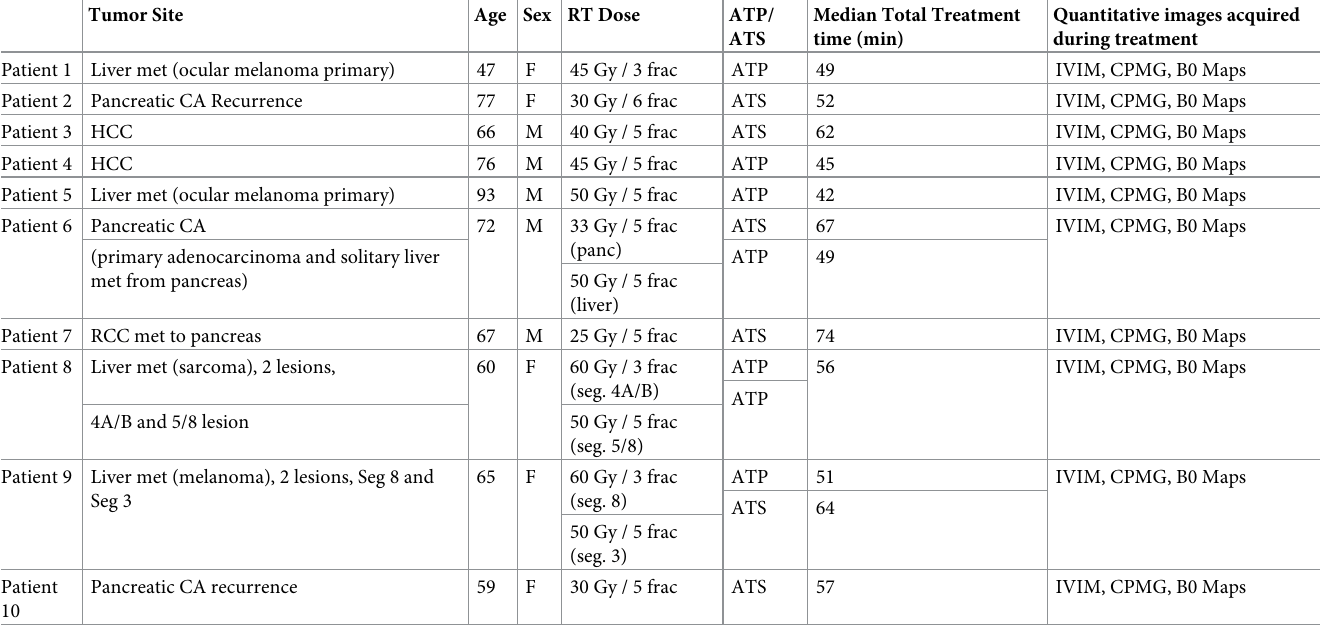
Table 1. Patient